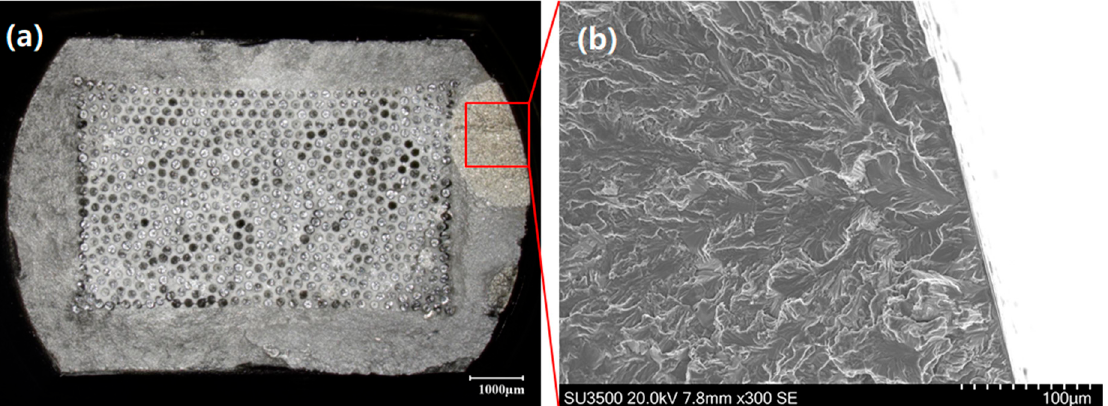
Figure 10. Surface crack initiation in in-phase test at 1100 MPa, where the subsequent crack grows first through the matrix material and then into the fibrous region. ( a ) Optical microscopy of the full fracture surface; ( b ) SEM image of primary surface crack initiation site.